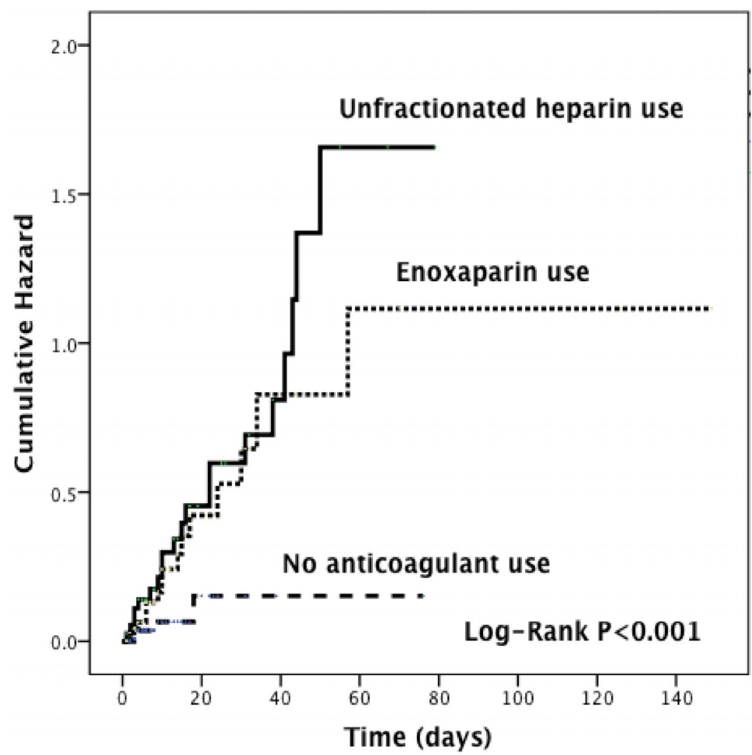
Figure 2. Kaplan-Meier estimates of cumulative hazard of major bleeding events with the use of unfractionated heparin or enoxaparin